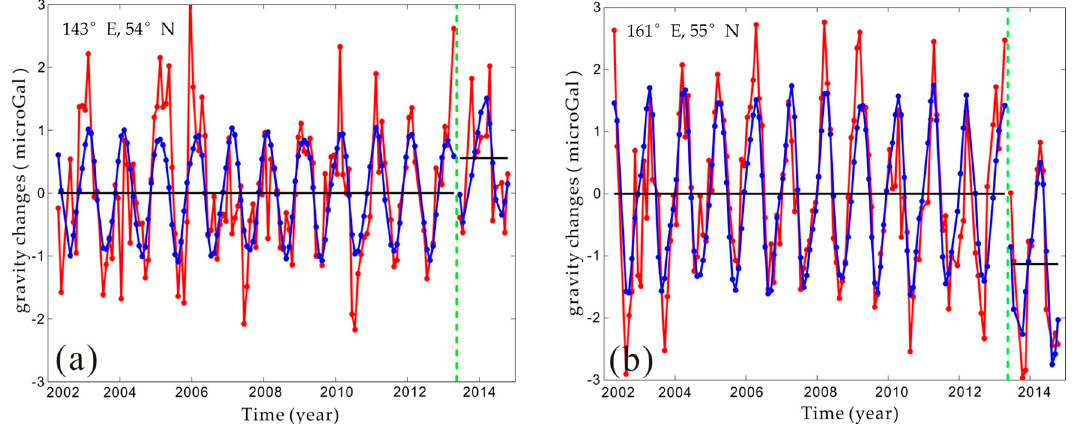
Figure 2. The time series at grid points (143° E, 54° N) and (161° E, 55° N) are shown by red dots in ( a ) and ( b ), respectively. The constant term and linear trend are removed. The red dots and red line represent the original gravity anomaly, and the blue dots and blue line represent the fitted gravity anomaly.